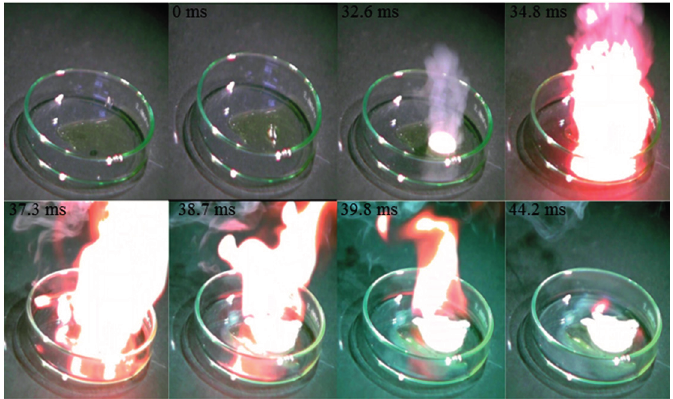
Figure 8. ID time photographs of the mixture hypergolic chemicals with [EMT] + [N 3 ] − and HOCH 2 CH 2 NHNH 2 using H 2 O 2 .